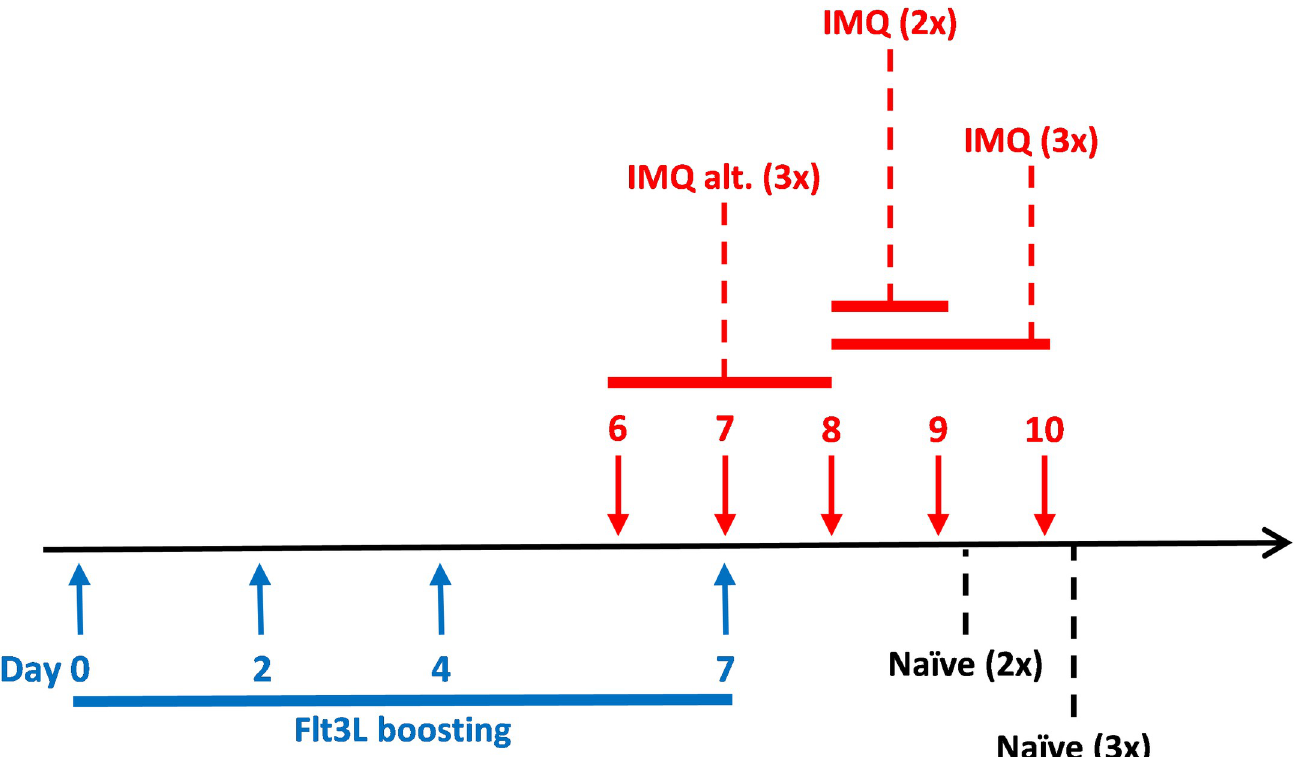
Fig 2. Study outline. The group denoted IMQ alt. (3x) initiated IMQ application the day before the final boost (day 6) and was dosed with IMQ on day 6, 7 and 8. The groups denoted IMQ (2x) and IMQ (3x) initiated IMQ application on the day after the final boost (day 8). Group IMQ (2x) was dosed with IMQ on day 8 and 9 and group IMQ (3x) was dosed with IMQ on day 8, 9 and 10. Boosted mice with a clipped back area were used as controls (denoted Na ï ve (2x) and (3x) indicating that the mice were either terminated along with the mice receiving two or three IMQ